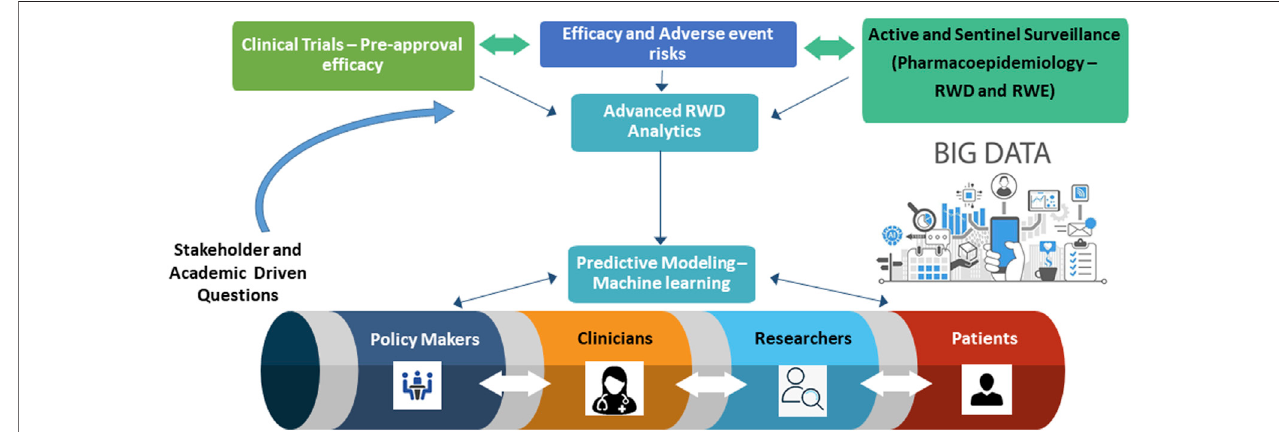
FIGURE 1 | Pharmacoepidemiology Research Paradigm - from research to policy to